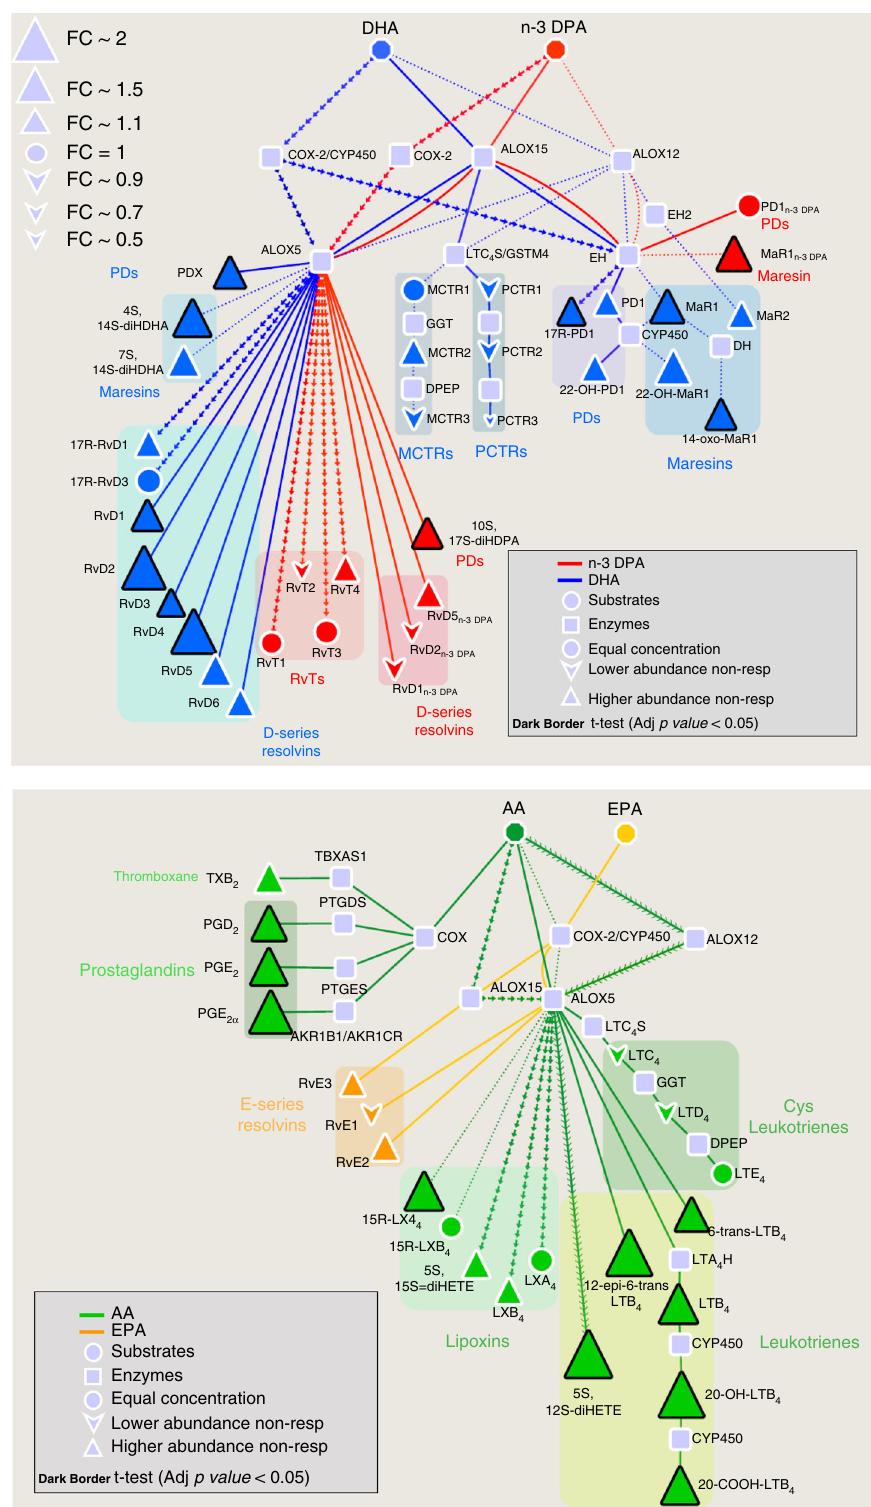
mediator pro fi les between DMARD responders and non- an increase in ALOX5 products from both the n-3 DPA and DHA metabolomes in non-responders with lympho-myeloid